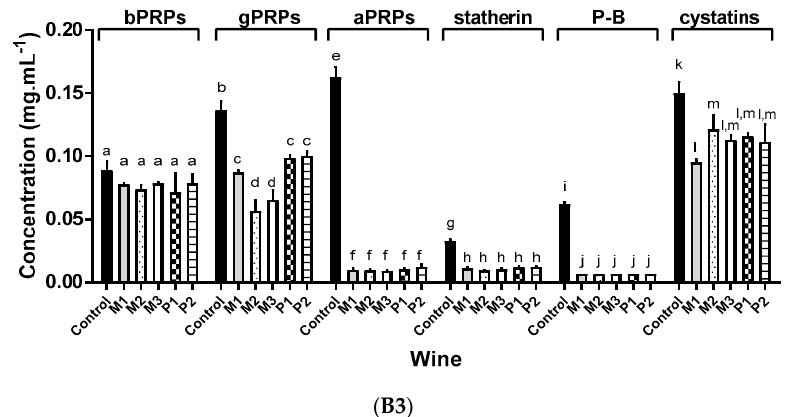
Figure 2. ( A ) Typical salivary protein profile obtained by HPLC analysis with detection at 214 nm, and identification of the major families eluted along the chromatogram, the identification of the different families has been previously reported [22,37]; bPRPs: basic proline-rich proteins, gPRPs: glycosylated proline-rich proteins, aPRPs: acidic proline-rich proteins. ( B ) Modifications in the concentration (mg mL − 1 ) for each family of salivary proteins upon the interaction with each wine (two bottles of M wine (M1 and M2) and three bottles of P wine (P1, P2, and P3)) at different ratios ( B1 ) 10:0.7, ( B2 ) 10:2, and ( B3 ) 10:3. Control condition is the concentration of each family of salivary proteins in human saliva in the absence of wine. Data are presented as mean and SEM of at least three independent experiments (values with the same letter are not significantly different, p < 0.05, ANOVA with Bonferroni correction for multiple comparisons).